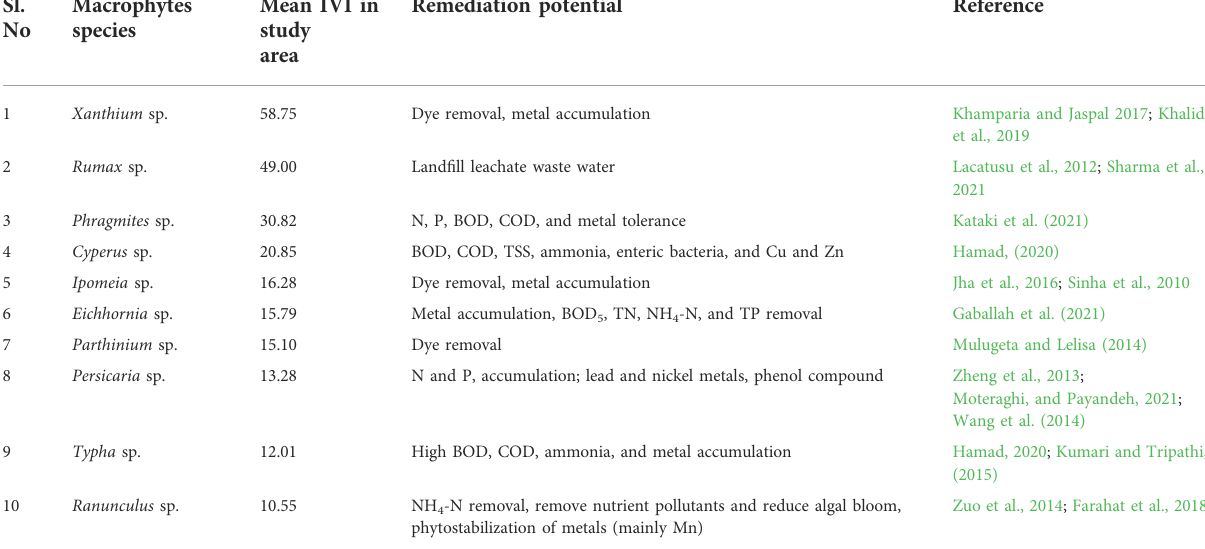
and biotic parameters analyzed for the TS station. Dissolved oxygen also correlated negatively with bacteria CFU (R = −